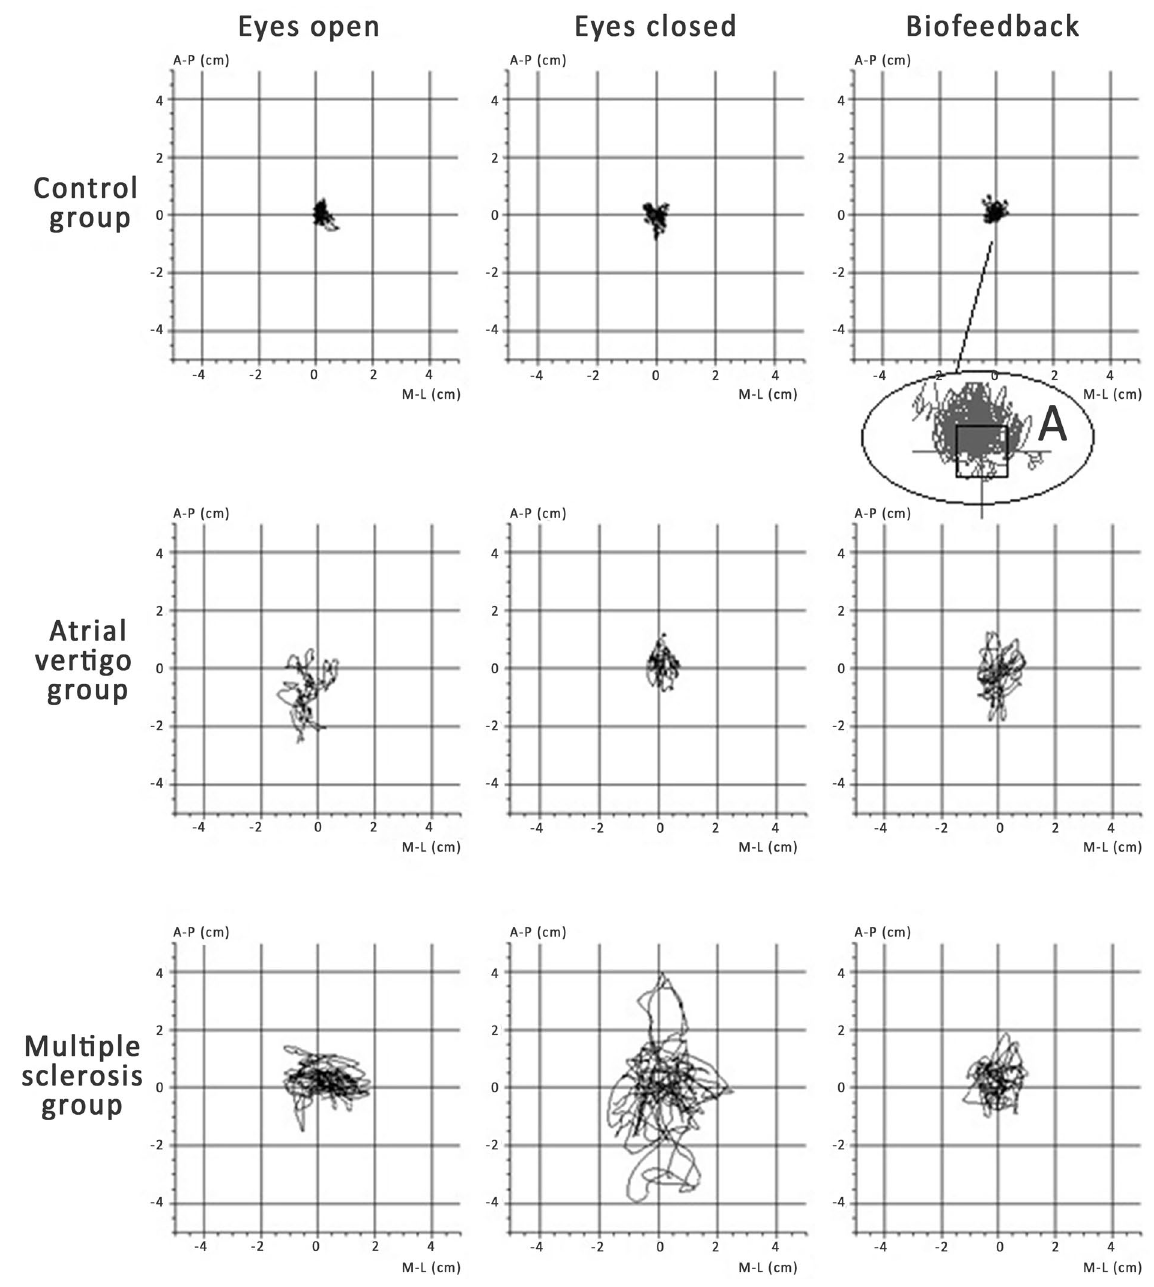
Figure 1. Exemplary result of posturographic examinations. A Conscious correction of the center of pressure position in the visual biofeedback